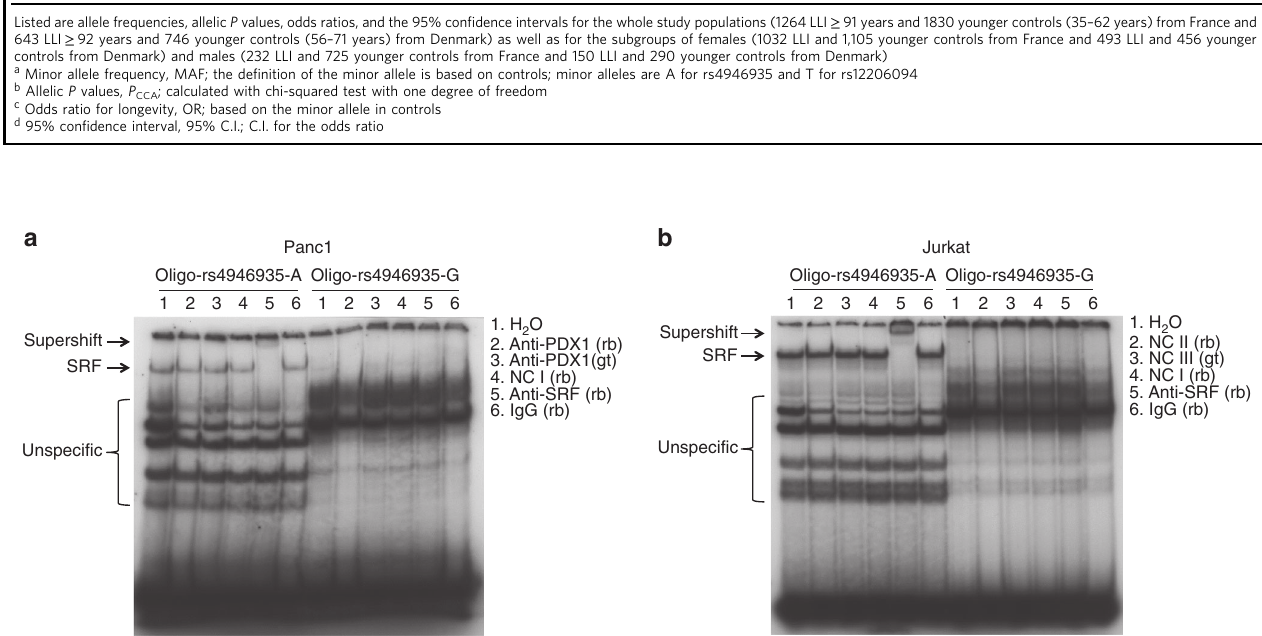
Fig. 2 SRF binds to the longevity allele A but not to the major allele G of rs4946935. Nuclear extracts from Panc1 a and Jurkat b cells were submitted to EMSA with the indicated oligonucleotides. Supershift experiments were performed with antibodies as listed. The position of the supershifted complex is indicated by an arrow. One biological replicate of four is shown. Gt goat, IgG immunoglobulin G, NC nonspeci fi c control (NC I: anti-STAT5A, rabbit; NC